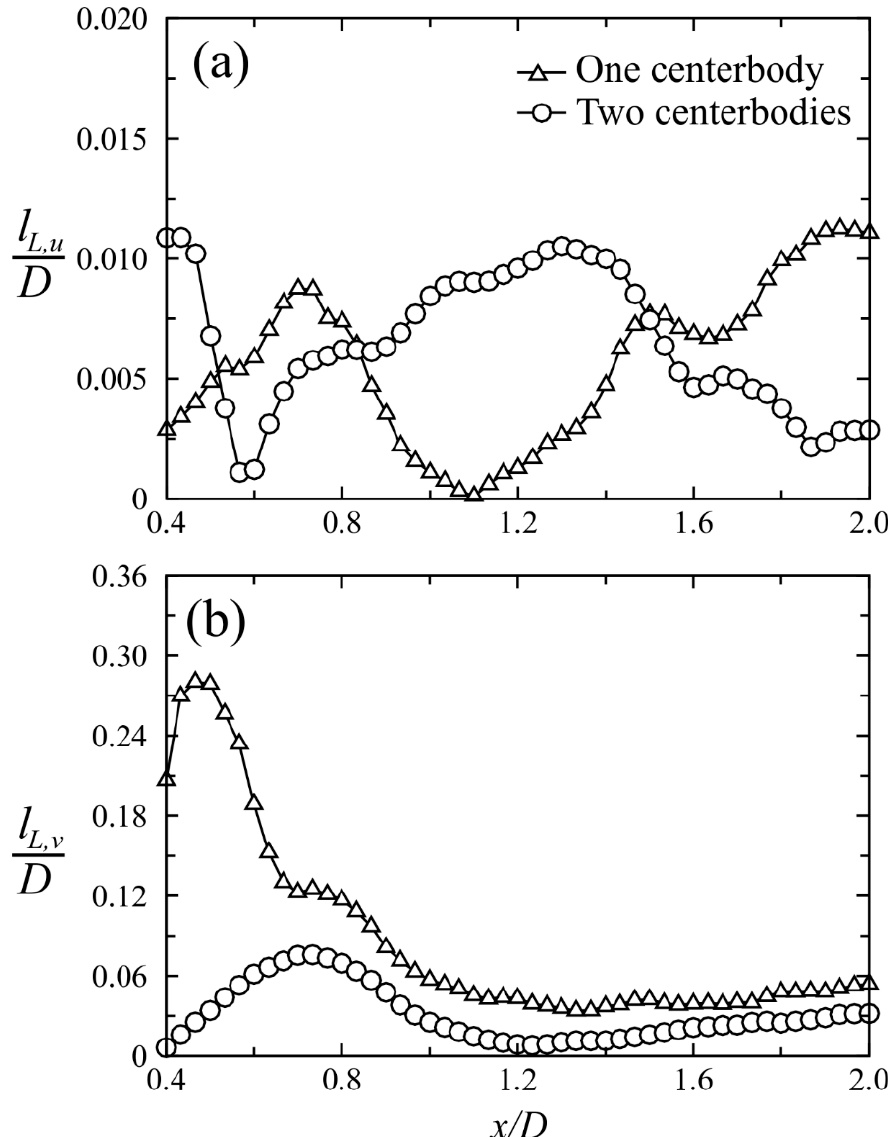
Figure 12. Normalized Lagrangian integral time length scales of turbulence eddies along centerline. ( a ) Axial component, ( b ) radial component. Re c = 280, Re a = 480, and S = 0.432.